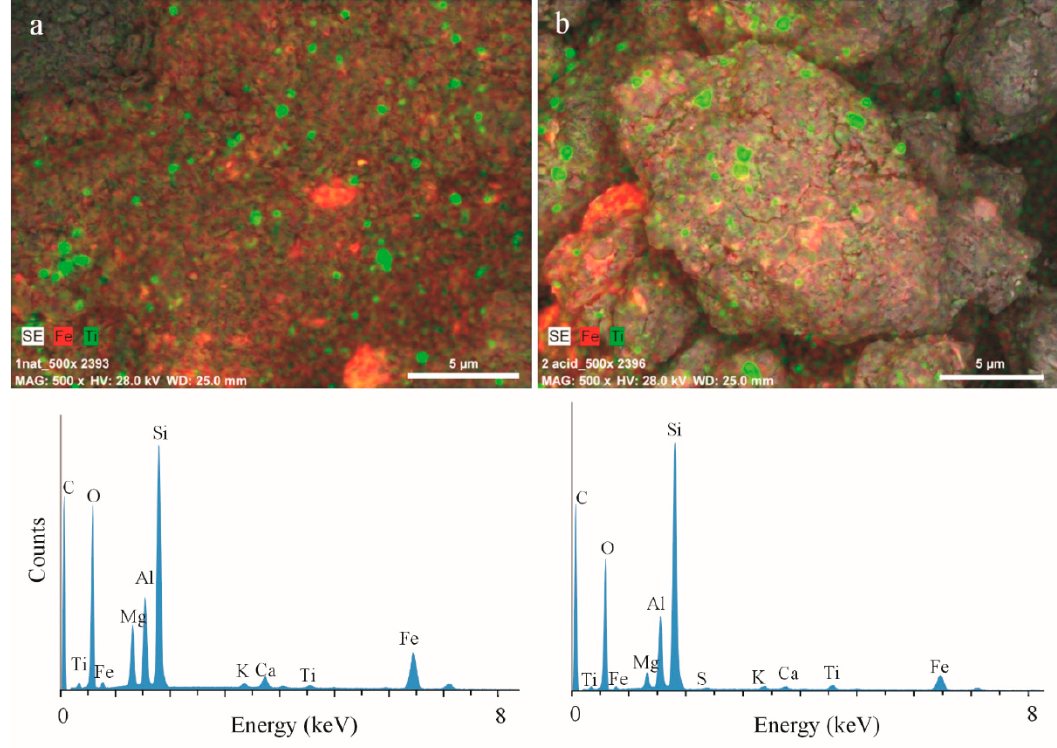
Figure 1. SEM photomicrographs and energy dispersive X-ray (EDX) spectra of saponite samples—( a ) raw and ( b ) acid-treated.